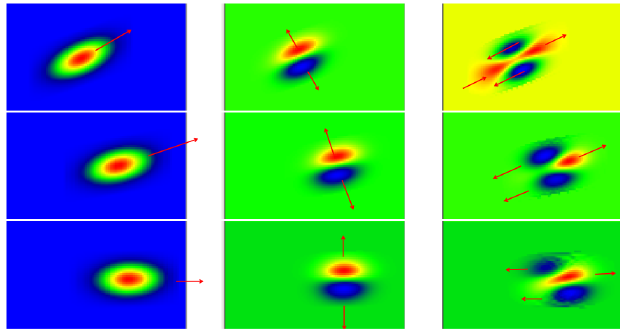
FIG. 9. Bunch charge distribution, transverse forces, and col- linear forces on the horizontal plane in the vertical center of the vacuum chamber at three time moments. The starting plots are at the bottom at the time when a bunch just enters the magnetic field. The left three vertical plots show a bunch charge distribu- tion. The red arrows show the direction of the bunch velocity. The middle three vertical plots show a transverse force. Again, the red arrows show the direction of the force. The right three vertical plots show the collinear force, which is responsible for an energy gain or energy